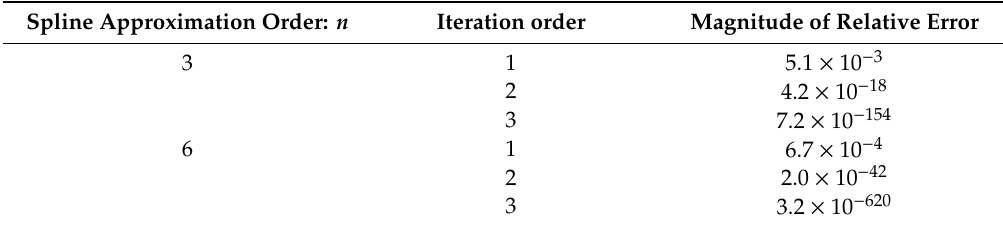
Table 7. Relative error in evaluation of x 1/ h o for the case of x o = 137, h = 6 and an initial estimate for x 1/ h